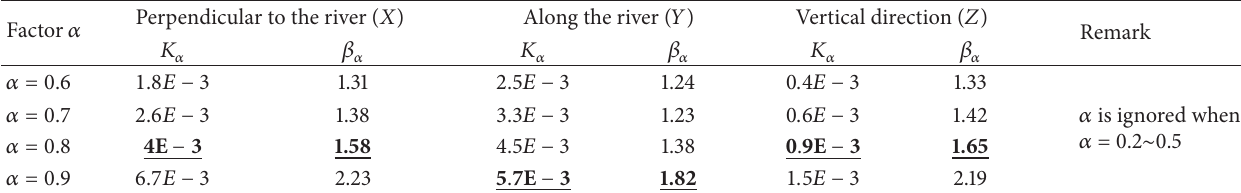
Table 1: DPTV of the auxiliary powerhouse floor at 1288.8 m. Units: W.